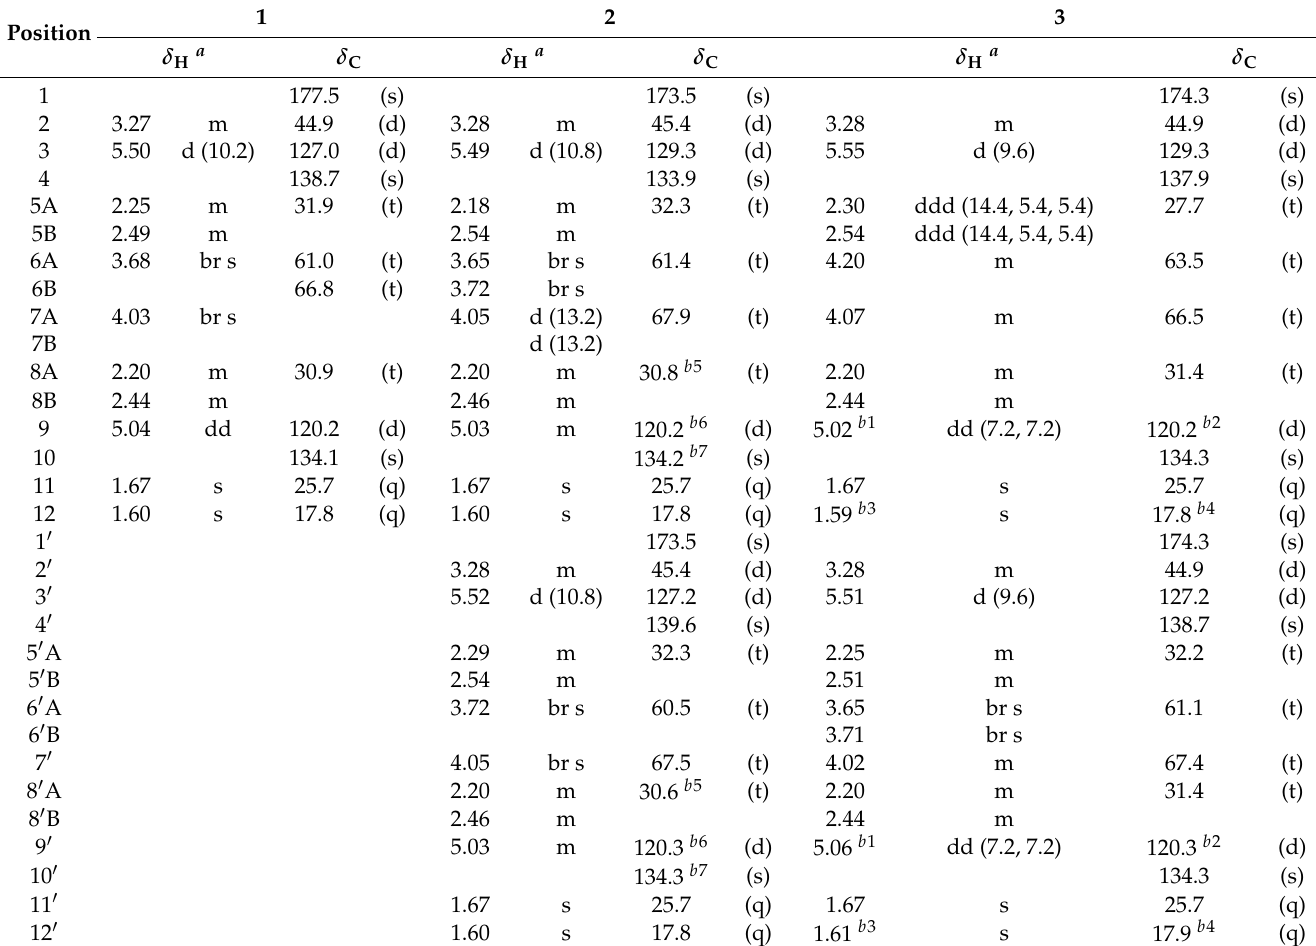
Table 1. 1 H and 13 C NMR spectral data for metabolites ( 1 – 3 ) in CDCl